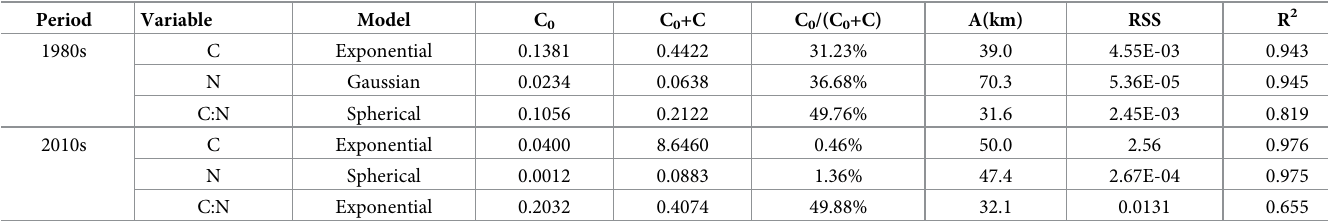
Table 2. Parameters of soil C, N contents and C:N ratio in semi-variogram model.